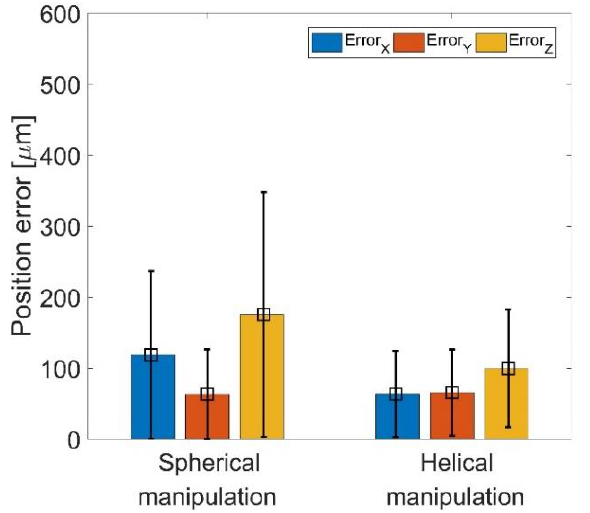
Figure 8. RMSE and SD of position error on the X-, Y-, and Z-axes in trajectory 1: spherical automated manipulation and trajectory 2: helical automated manipulation.